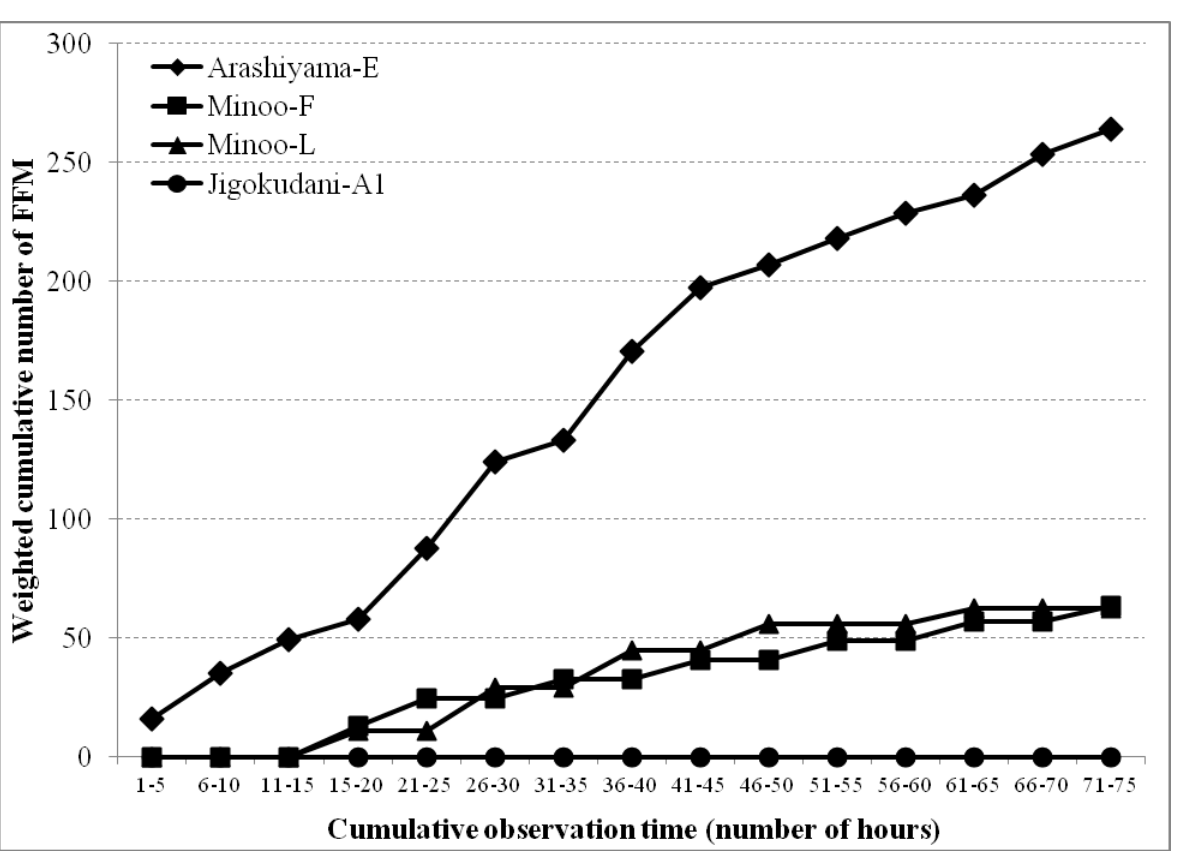
Figure 2 . A) Inter-group differences in the cumulative number of FMM observed (weighted by group-specific numbers of females and males being developmentally able to engage in FMM) over the study period. B) Inter-group differences in the cumulative number of FFM observed (weighted by group-specific numbers of females being developmentally able to engage in FFM) over the study